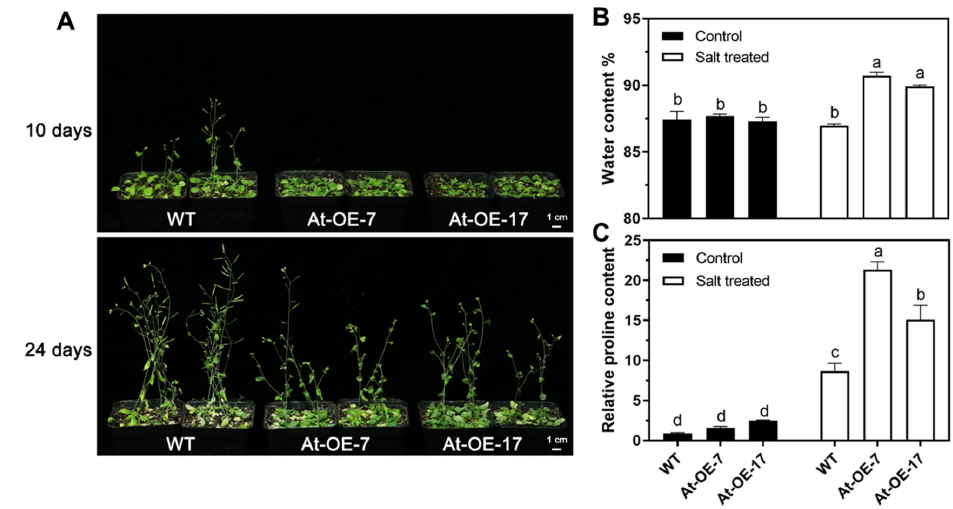
Figure 3. Growth and physiological differences of Mtr-miR319a overexpressing Arabidopsis plants after salt stress: Phenotype ( A ), physiology indicators of water content ( B ), and relative proline content ( C ) of Arabidopsis plants overexpressing Mtr-miR319a after salt stress. The WT Arabidopsis plants, Mtr-miR319a- overexpressing plants of At-OE-7 and At-OE-17 were exposed to salt stress of 200 mM NaCl for 10 d ( A ) and 24 d ( A – C ). The values are shown as mean ± standard error (SE); n = 3 for all groups. The bars represent the SE. Bars with different lowercase letters indicate statistically significant differences at p < 0.05 based on ANOVA. Bar = 1 cm.